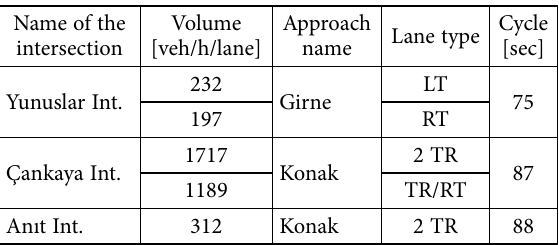
Table 9. Information about the control intersections for model validation